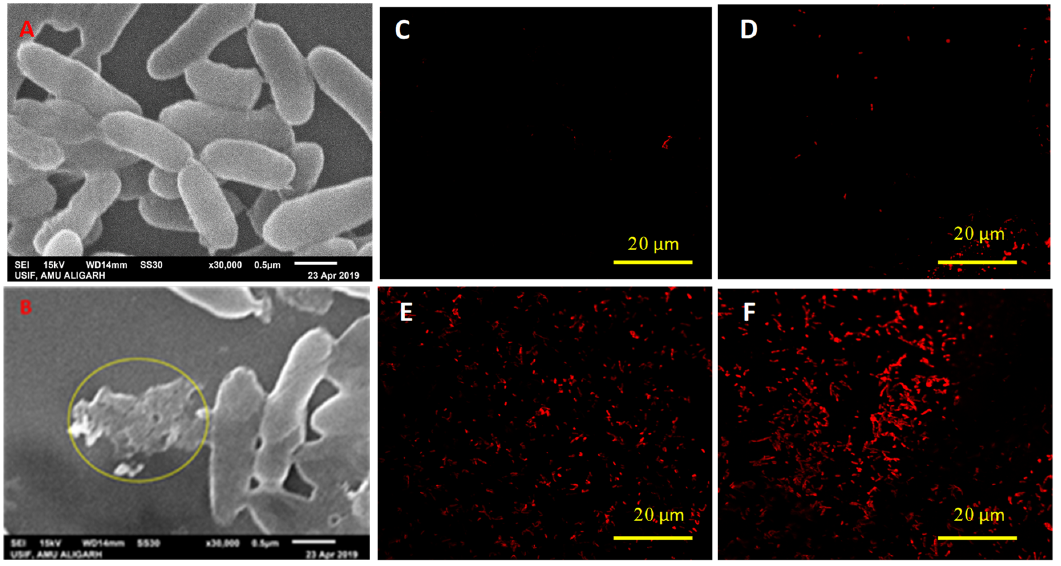
Figure 3. Scanning electron microscopic images of Pseudomonas sp. PS3. ( A ) untreated/control cells; and ( B ) cells treated with 1000 μg hexaconazole (HEXA) mL −1 . The yellow circle shows